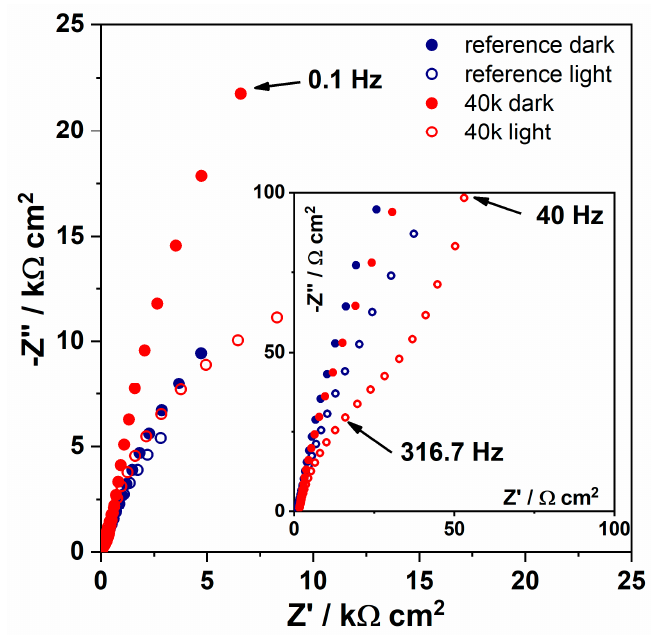
Figure 7. Nyquist representation of impedance spectra for Ni-decorated titania (40k) and reference material recorded in dark and under UV-vis irradiation.